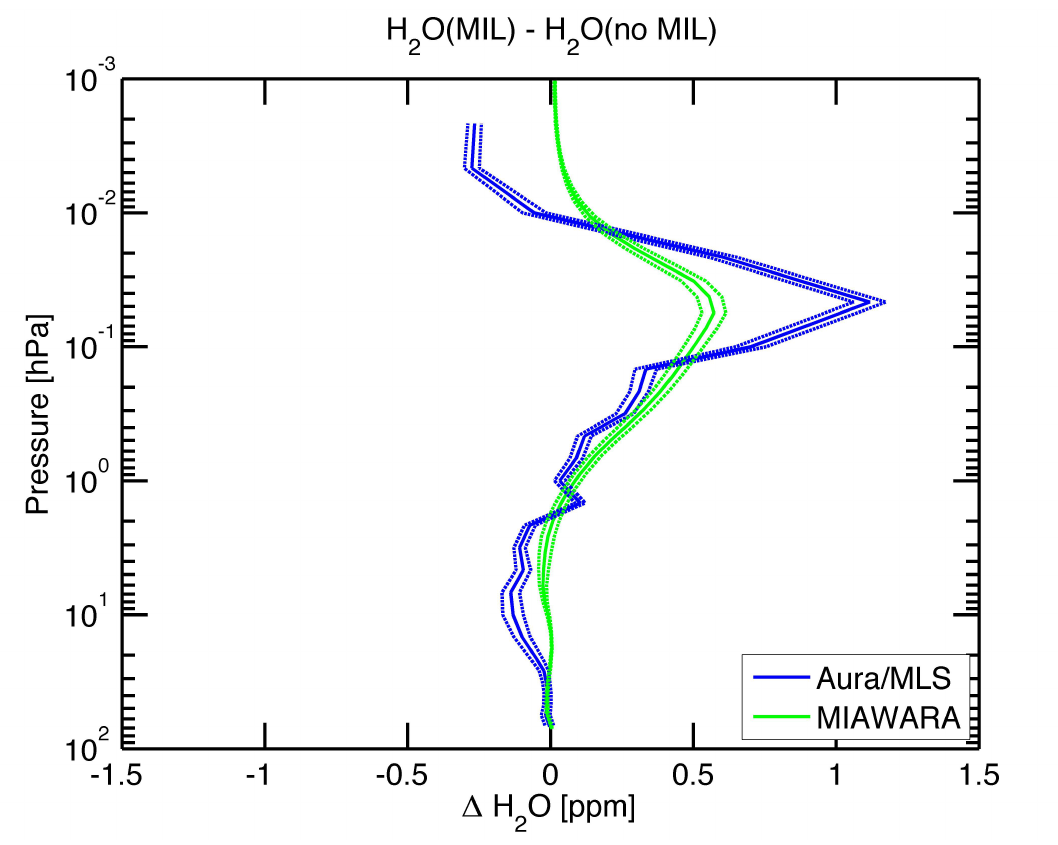
Figure 7. Difference profiles “MIL” minus “no MIL” for water vapour observations by MIAWARA (green) and by Aura/MLS (blue) above Bern during winter. Dashed lines show the error of the